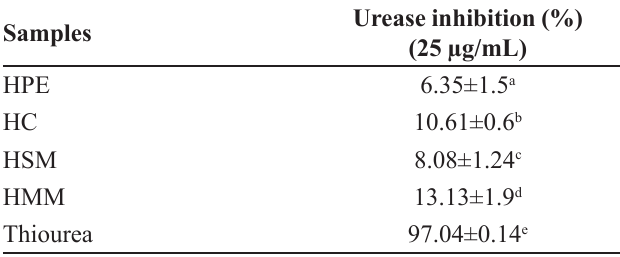
TABLE III - The urease inhibitory activity of different extracts from H. plicatum subsp.